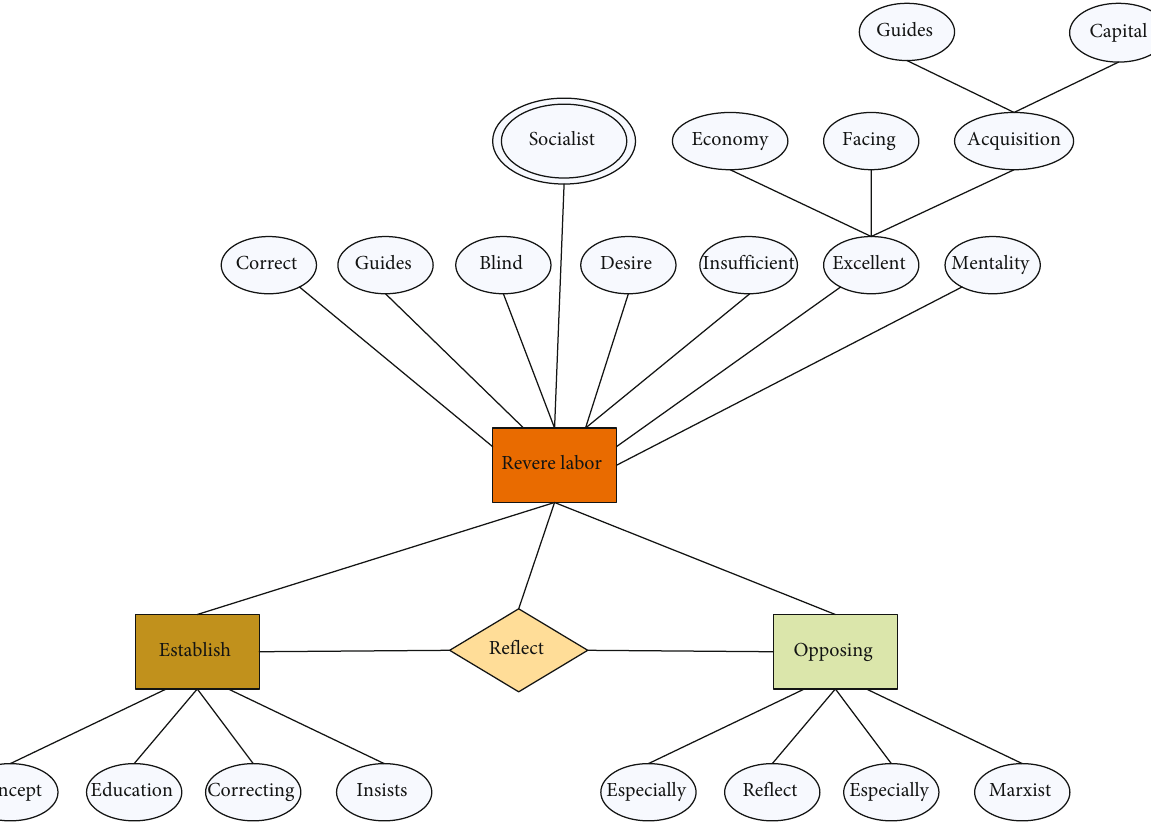
Figure 3: Design of labor education curriculum for college